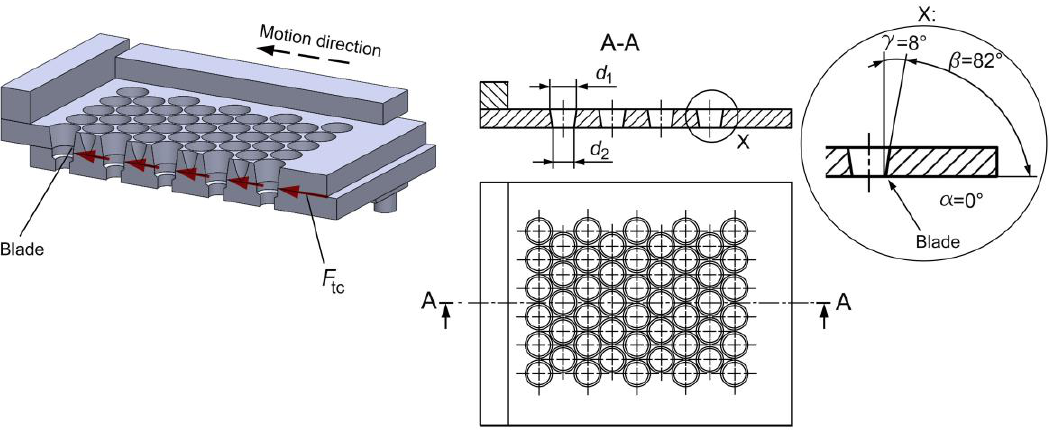
Figure 7. Design variant of commercial knife.